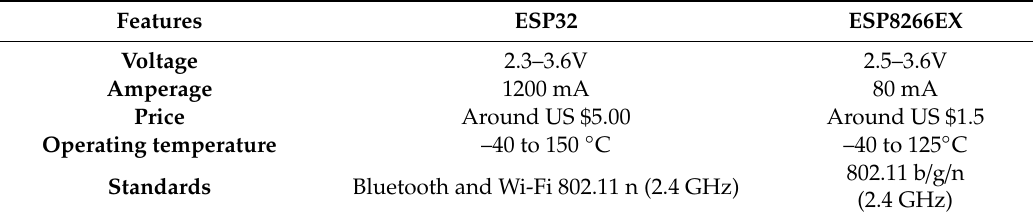
Table 2. Wi-Fi module